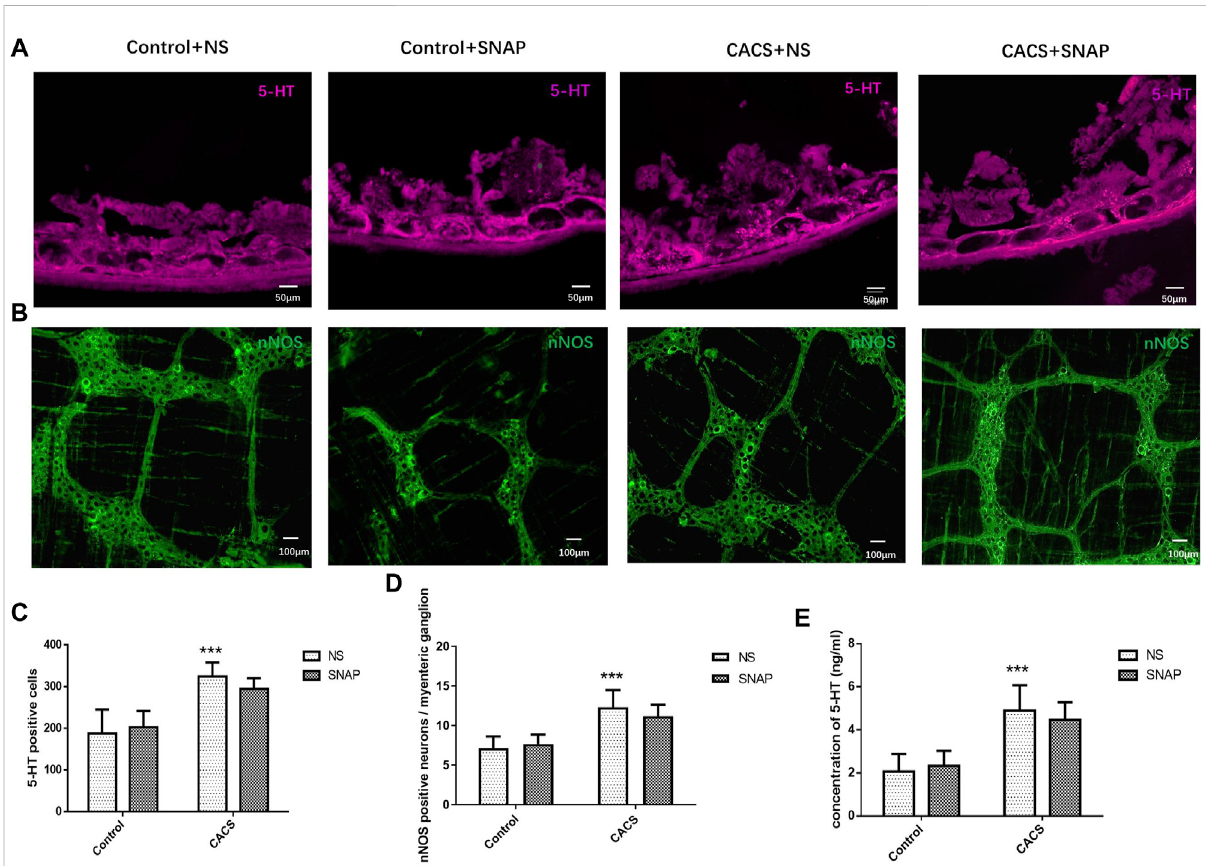
FIGURE 7 SNAPmicroinjection into theBLA didnotmodify theexpression ofnNOS or5-HTinCACS mice. (A,C,E) EffectsofSNAP microinjectionintothe BLA on 5-HT expressioninthe colons ofthe CACS model mice. The number of5-HT-positive cells and concentration increased in themodel group butdidnotdecreasesigni fi cantlyintheSNAPgroup. (B,D) EffectsofSNAPmicroinjectionintotheBLAonnNOSexpressioninthecolonsoftheCACS modelmice.ThenumberofnNOS-positivecellsincreasedinthemodelgroupbutdidnotdecreasesigni fi cantlyintheSNAPgroup.Thedataare presented as themean ± SEM ( n = 6 – 8 mice per group). * p < 0.05, ** p < 0.01, *** p < 0.001 versus thecontrol group, # p < 0.05, ## p < 0.01, ### p < 0.001 versus the CACS + NS